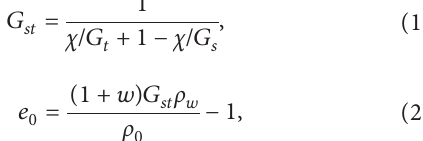
(USCS), the soil is classified as clay of high plasticity